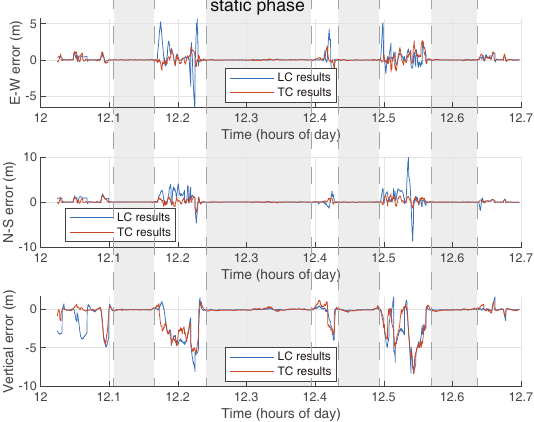
Figure 8: 3-dimensional error plots of track 2 in n-frame.